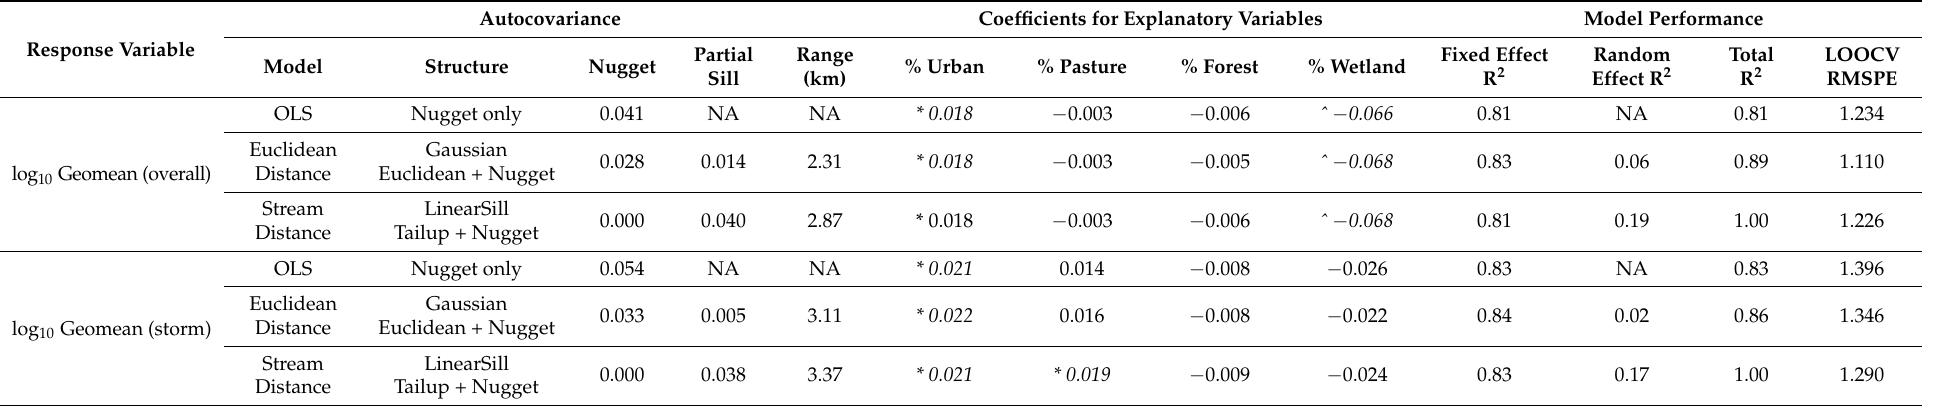
Table 2. SSN model autocovariance structures, coefficients for explanatory variables, and performance for two response variables (overall geometric mean of E. coli and geometric mean of E. coli during storm